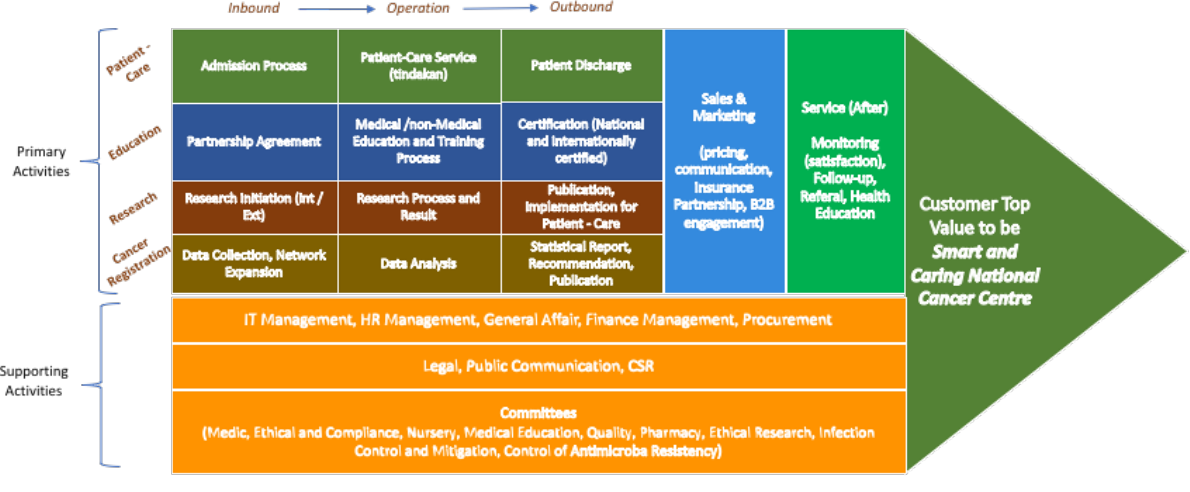
Figure 4. Value Chain Diagram of